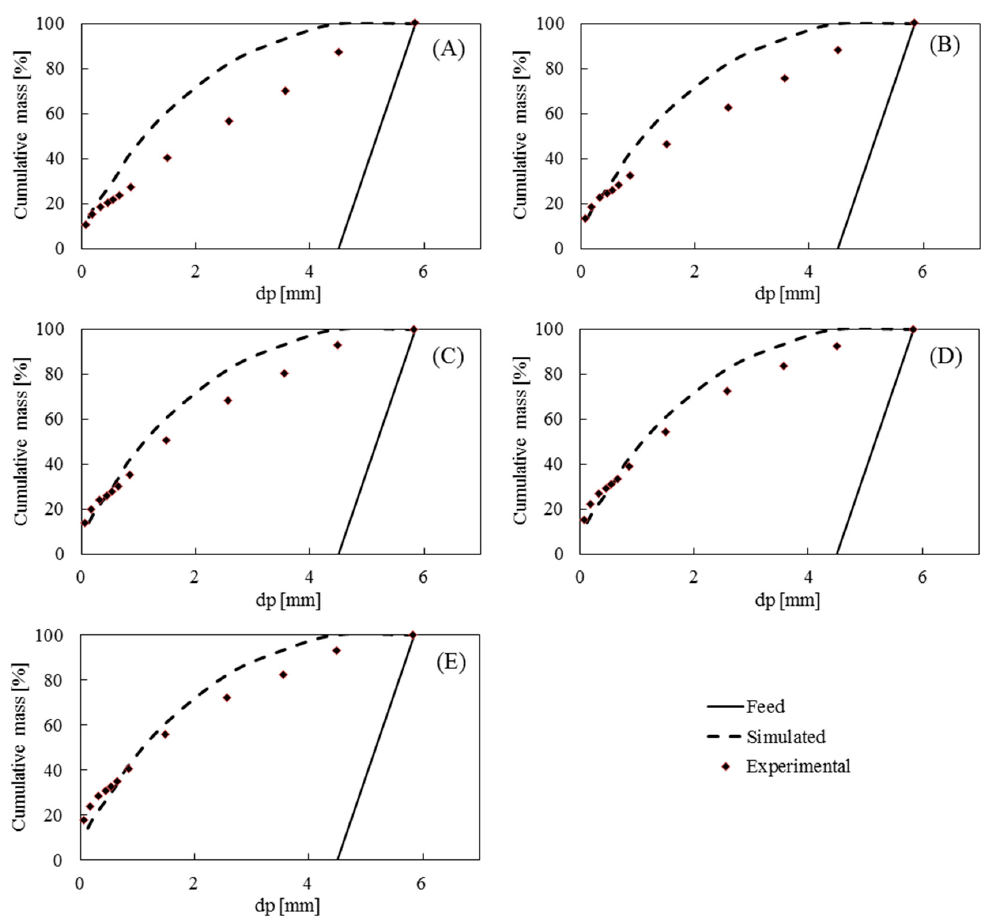
Figure 18. Feed, experimental and simulated curves using the calc-silicate material showing the effect of varying the specific pressing force; ( A ) MP-1; ( B ) MP-2; ( C ) M P-3; ( D ) MP-4 and ( E ) MP-5.